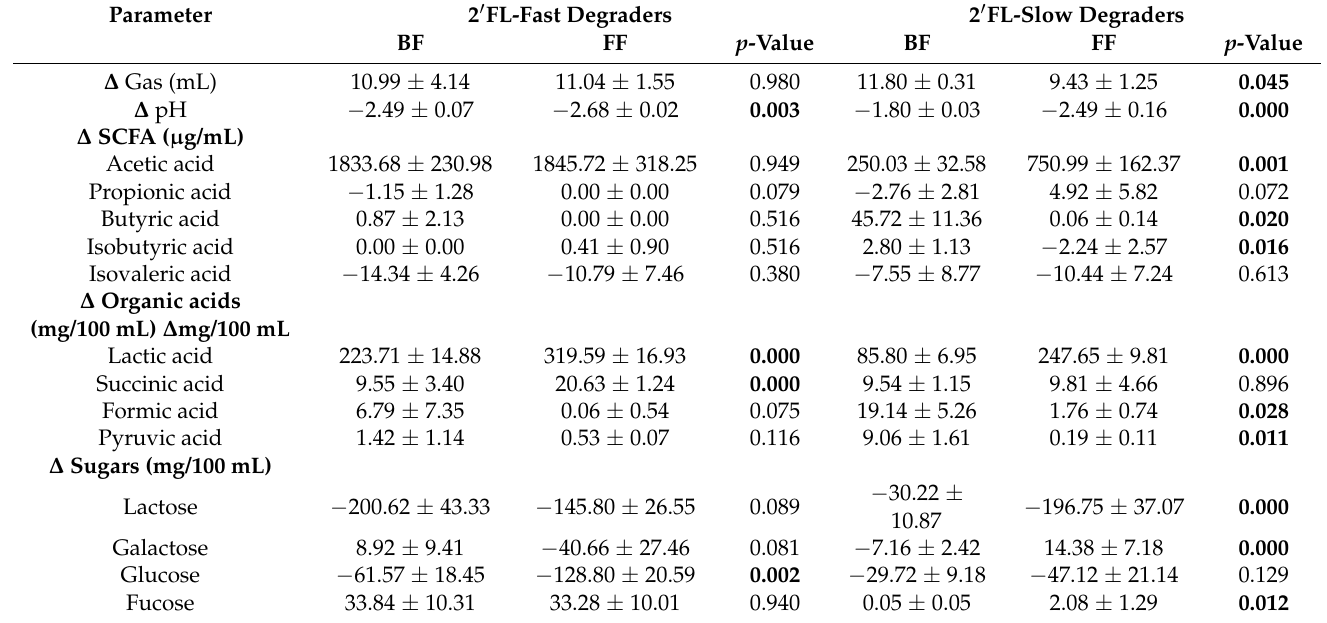
Table 2. Variations from baseline ( ∆ ) in the levels of gas, pH, SCFA, organic acids and sugars after 24 h of incubation in fecal cultures with fast and slow fermenting microbiotas according to the feeding type (BF or FF). Significant differences are highlighted in bold ( p -value <